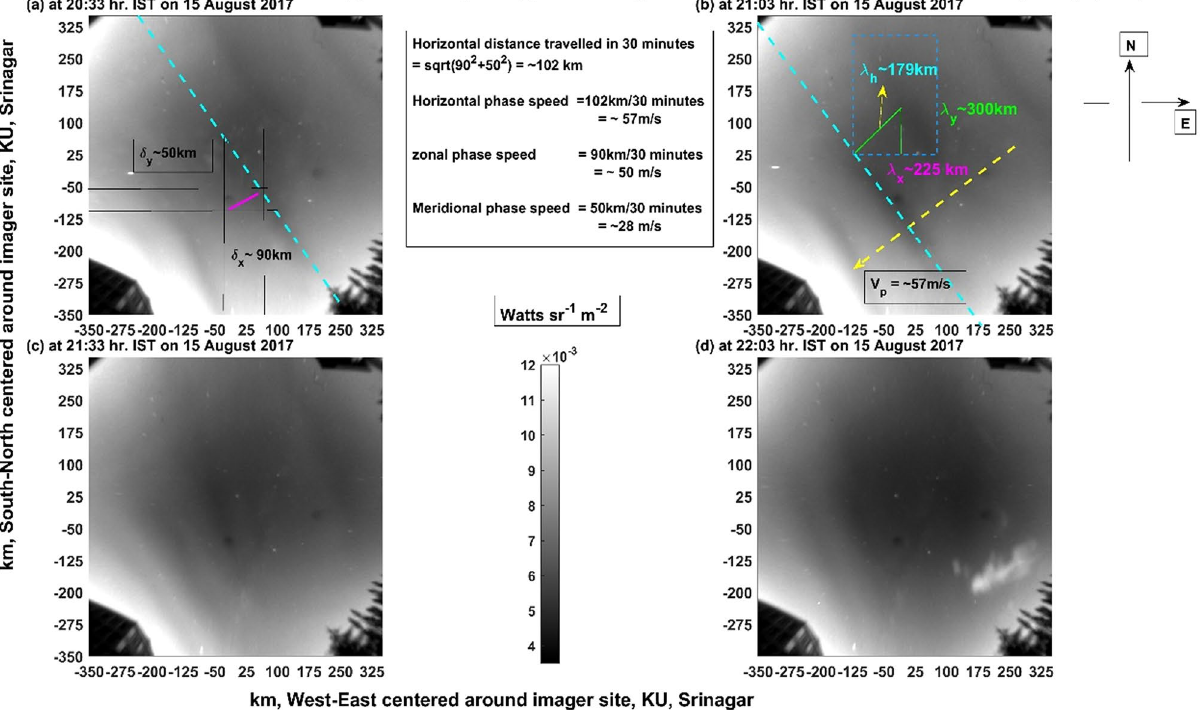
Figure 2. Illustrates the rectilinear-geographical spatial information of 630 nm emissions as shown in Fig. 1 (on 15 August 2017) for four scans separated by half an hour. While the y axes (zenith angle of − 57°–57°) run from South (bottom) to North (top), the x axes (zenith angle of − 57°–57°) run from West (left) to East (right) centred over KU, Srinagar. The colour bar values (emission intensity) are given in W sr −1 m −2 which can be